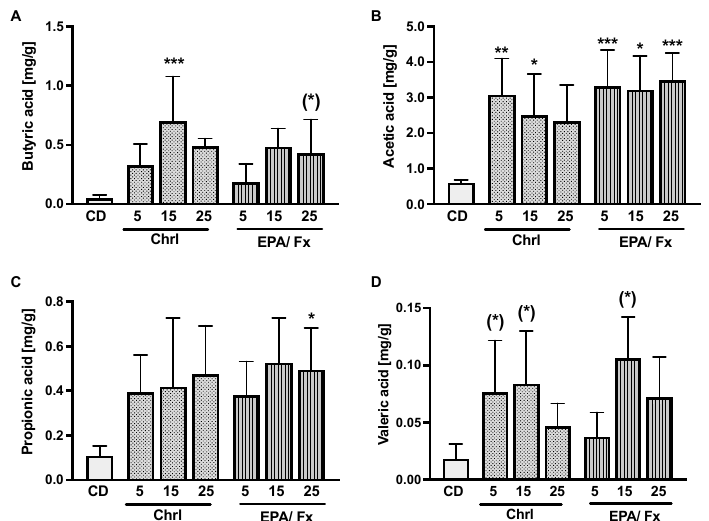
Figure 2. The microalgae diets increased the content of SCFAs, such as butyric acid ( A ), acetic acid ( B ), and propionic acid ( C ), with an increasing tendency of valeric acid ( D ), in feces after supplementation with both versions of the microalgae as measured on day 14 by gas chromatography. Data are expressed as mean ± SD (CD n = 5; Chrl5 n = 7, Chrl15 n = 6, Chrl25 n = 3, EPA/Fx5 n = 7, EPA/Fx15 n = 2, EPA/Fx25 n = 6). Statistics: * indicates differences from CD. (*) p < 0.1, * p < 0.05, ** p < 0.01, *** p < 0.001. Abbreviations: see Figure 1. Table 3. Intestinal and inflammatory markers measured in the ileum tissue.